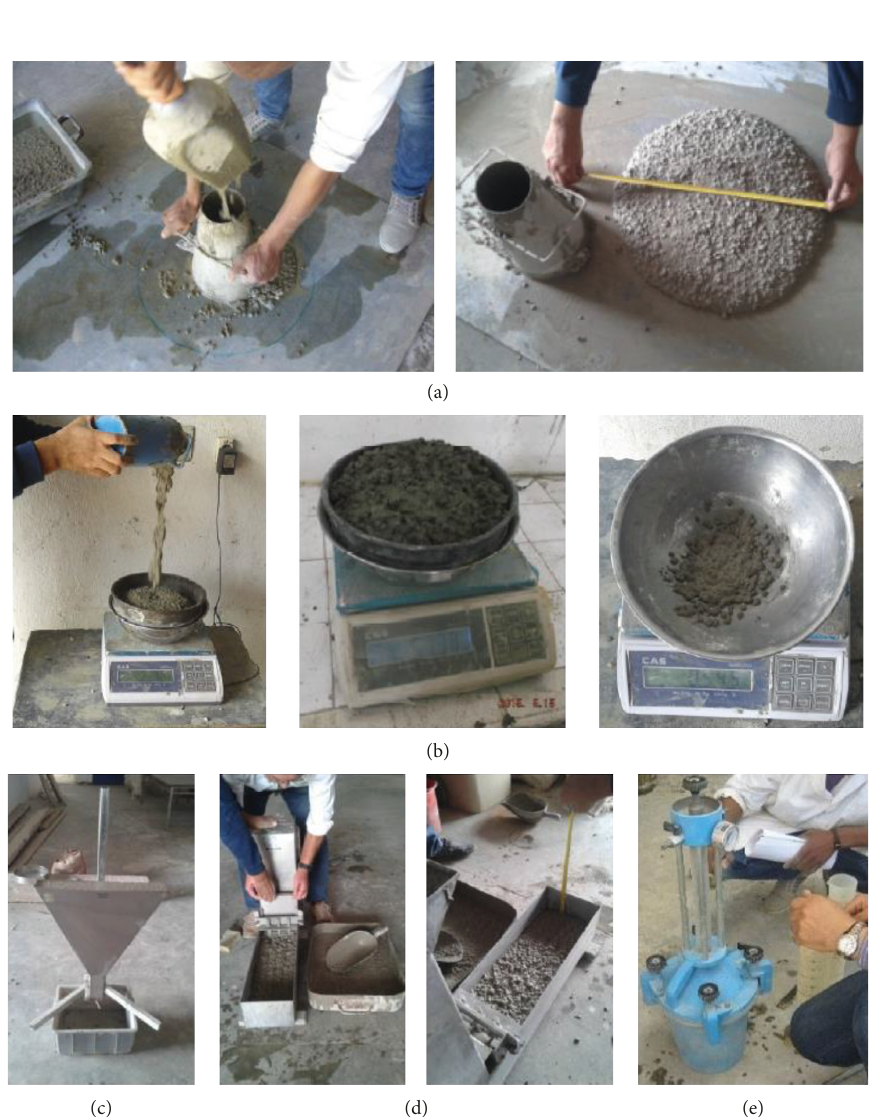
Figure 2: The tests carried out on SCC. (a) Slump flow test. (b) Sieve stability test. (c) L-box test. (d) V-funnel test. (e) Air content